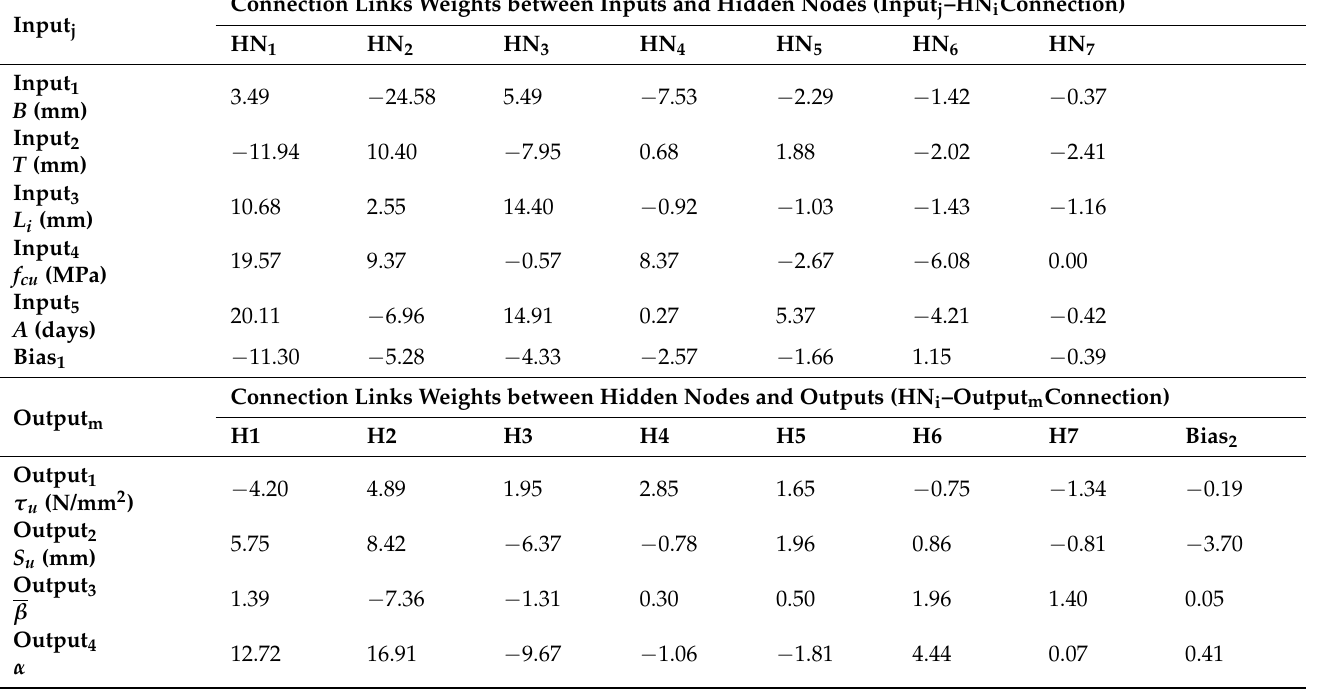
Table 4. Connection links weight used in 5-7-4 ANN2.